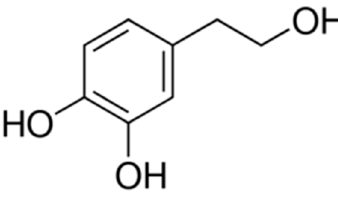
Figure 1. Chemical Structure of hydroxytyrosol (HT).